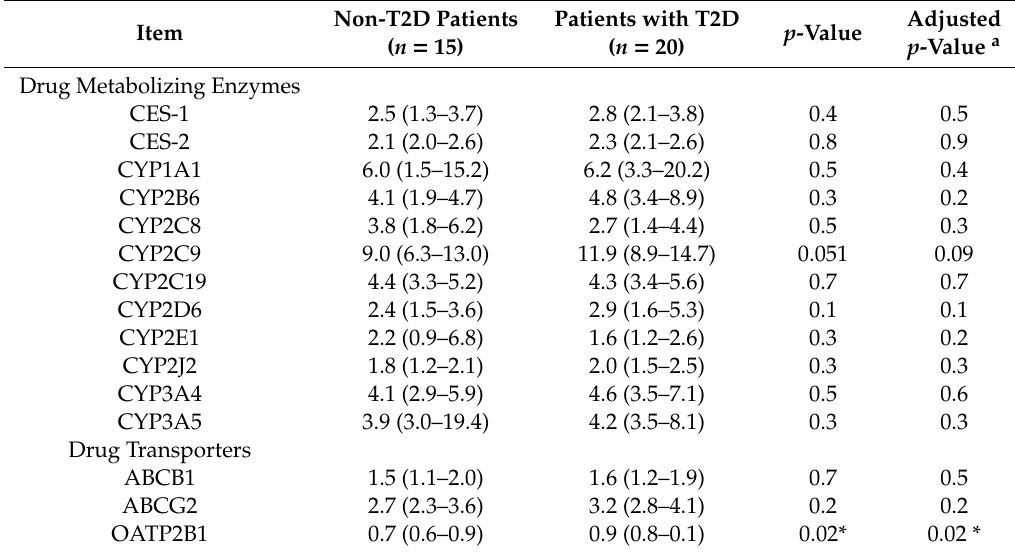
Table 2. mRNA transcripts for drug metabolizing enzymes and transporters in duodenal biopsy homogenates from non-T2D participants and patients with T2D.